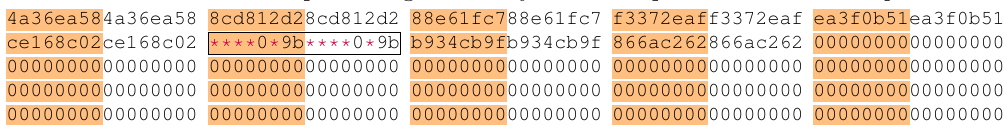
Table 5: The state representing the self-symmetric input states of Keccak -